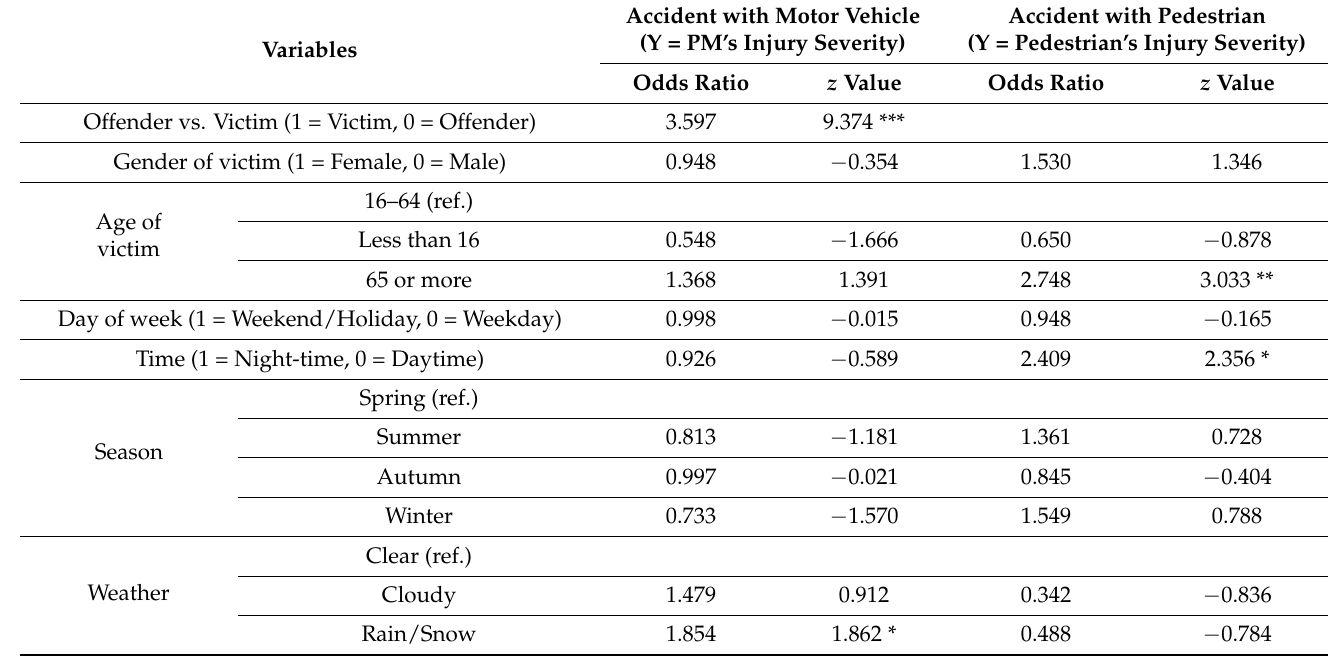
Table 7. Estimated results of injury severity model of PM